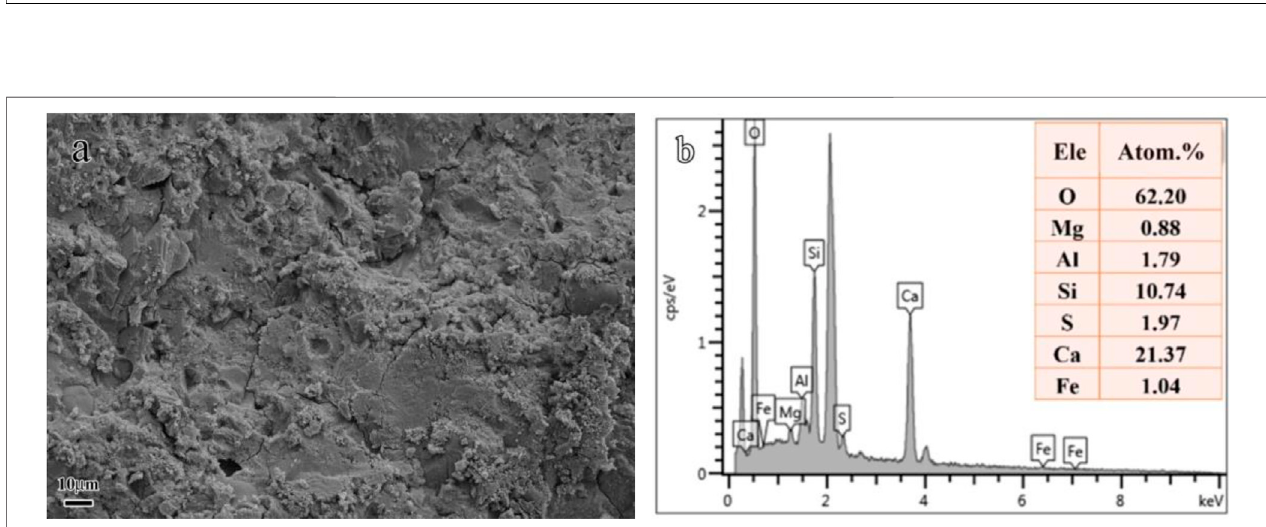
FIGURE 10 | SEM morphology and corresponding EDS results of the cement paste in concrete modi fi ed with nano SiO 2 before F/T and W/D cycles.